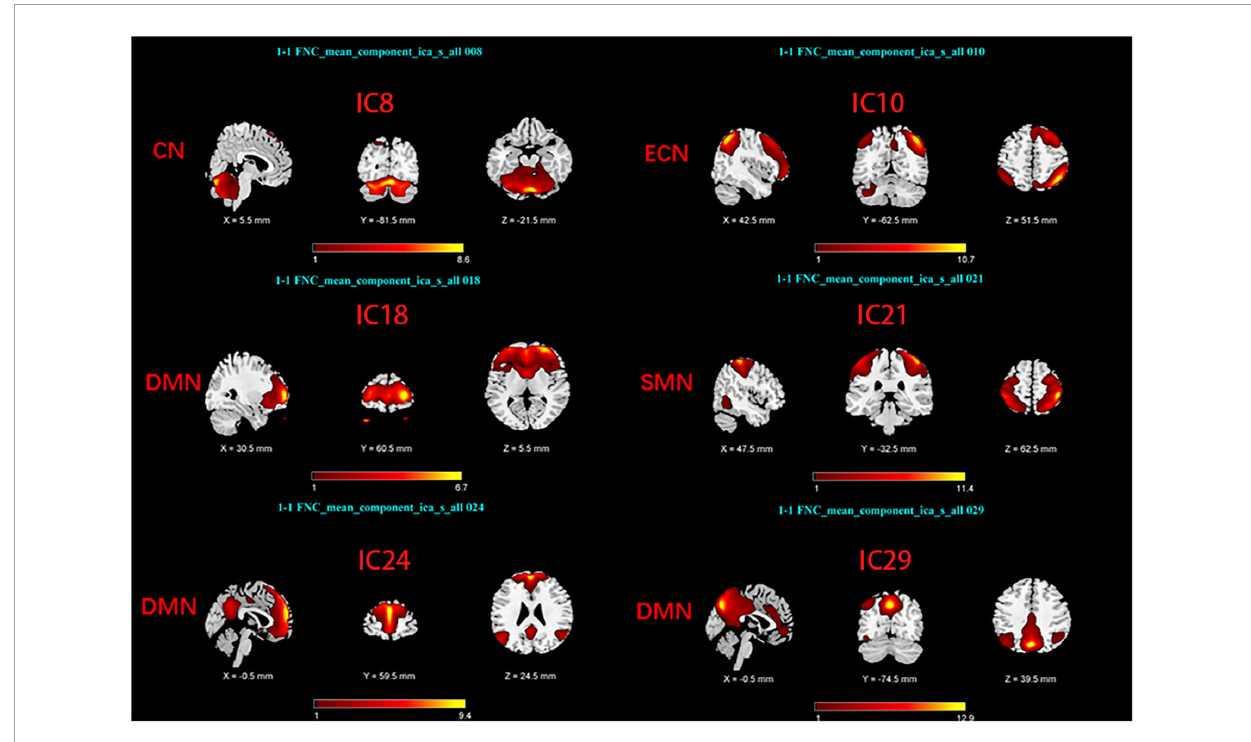
FIGURE2 Spatial maps of brain networks of LOPD and OCs. SMN, sensorimotor network; DMN, default mode network; ECN, executive control network; CN, cerebellar network.